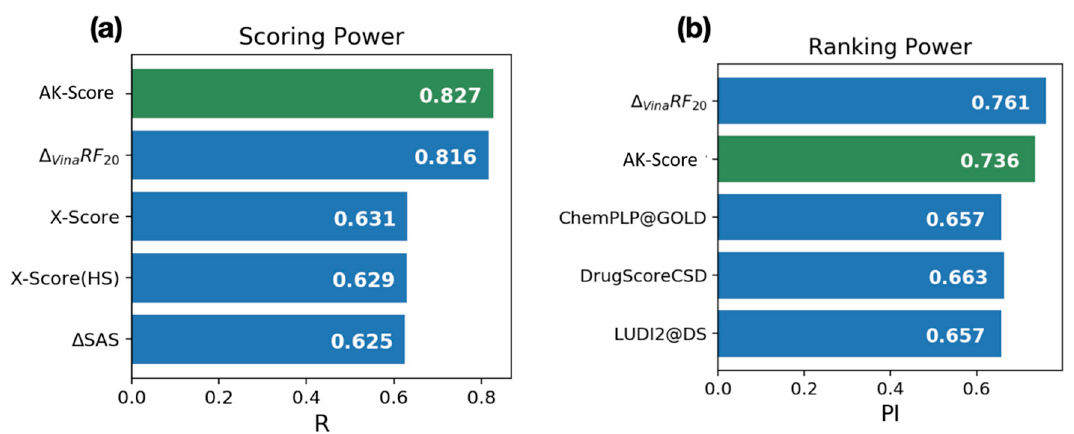
Figure 3. Benchmark results of AK-score with existing protein-ligand binding affinity scoring functions; ( a ) Scoring power ( b ) Ranking power. In each panel, AK-score is shown in green, and the other top 4 scoring functions from Su et al. [43] are shown in blue.